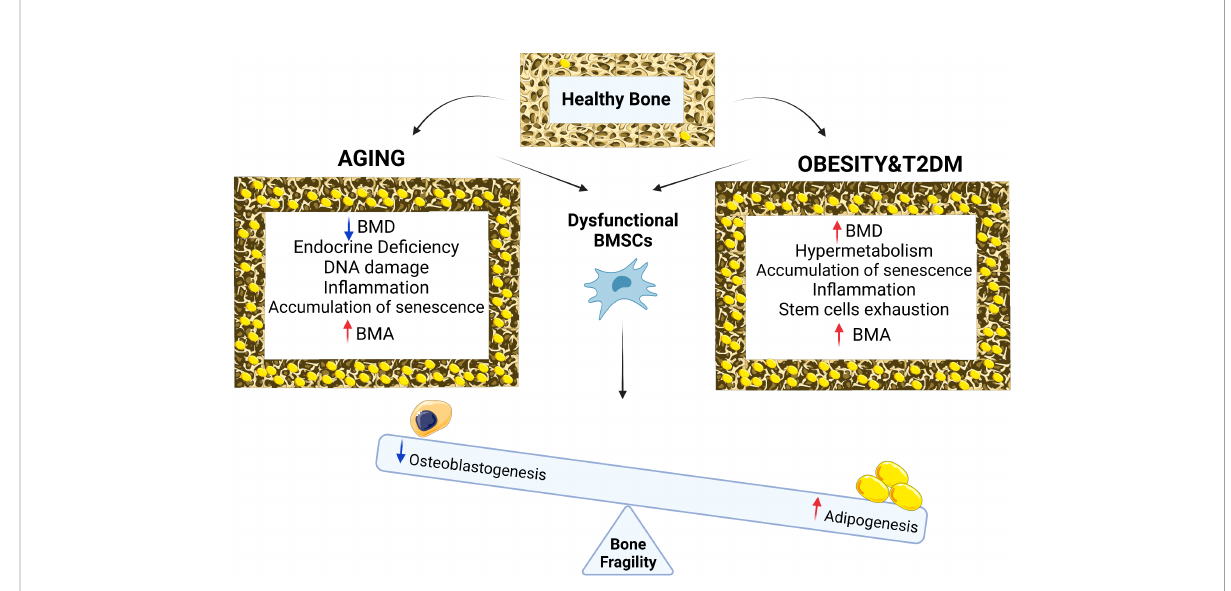
FIGURE 1 Chronological aging in bone is associated with reduction in BMD, endocrine de fi ciency, DNA damage, in fl ammation, accumulation of senescence, BMA and osteoporotic bone phenotype while with metabolic diseases such as obesity and type 2 diabetes, bone phenotype is associated with increased in BMD, cellular hypermetabolism, stem cell exhaustion, accumulation of senescence, in fl ammation, BMA and osteoporotic bone phenotype. Both conditions (aging vs metabolic diseases of obesity and T2D) result in BMSCs dysfunction leading to differentiation imbalance decreasing osteogenesis, increasing adipogenesis, BMA and bone